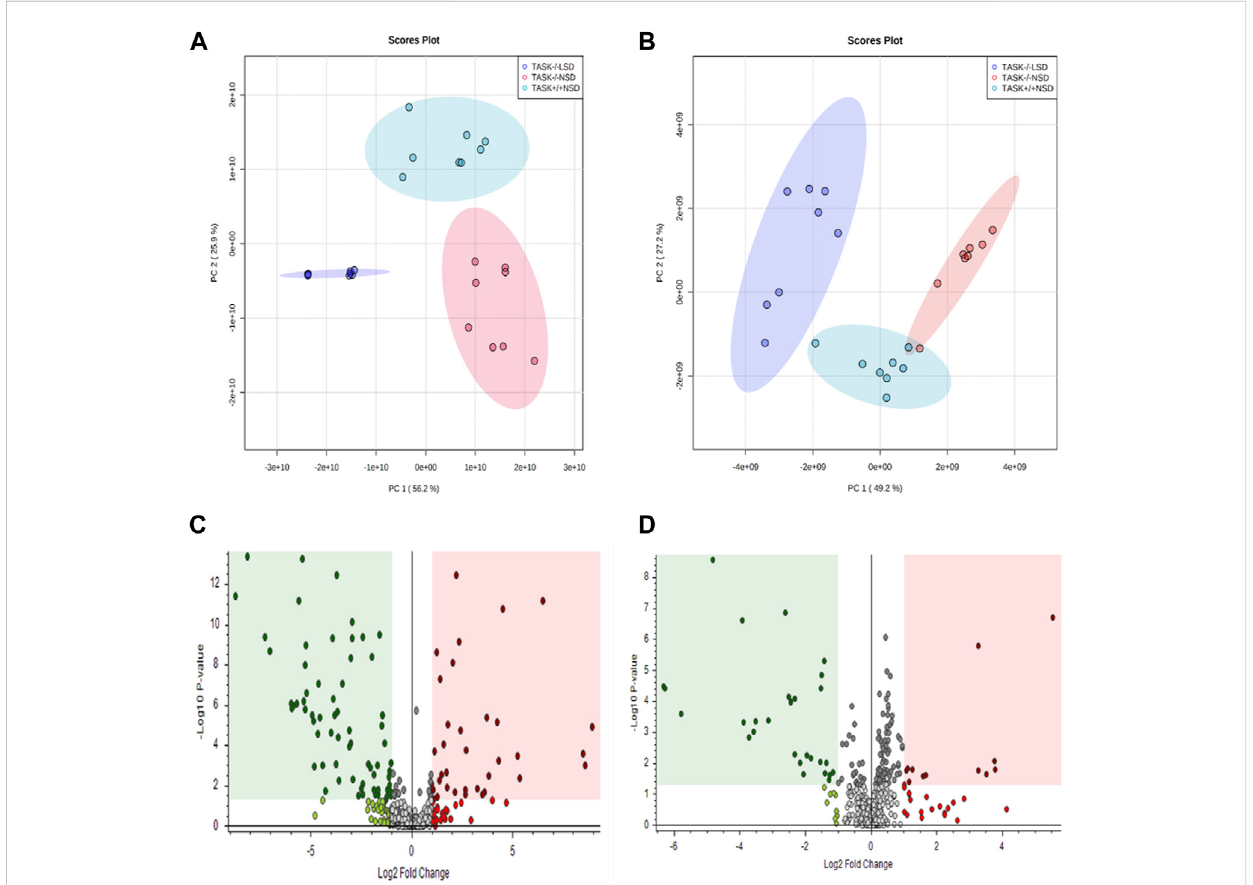
Principal component analysis and volcano plots of detected metabolites in positive mode and negative mode. PCA scores were plotted using positive (A) and negative (B) ion mode datasets for the TASK +/+ -NSD, TASK − / − -NSD, and TASK − / − -LSD groups. PC1, Principal component 1; PC2, Principal component 2. The volcano plots show the differential expression of metabolites between the TASK +/+ -NSD and TASK − / − -NSD groups under positive (C) and negative (D) ion mode. Log 2 Fold change is shown for TASK − / − -NSD versus TASK +/+ -NSD. The pink areas represent signi fi cantly upregulated metabolites, and the green areas indicate signi fi cantly downregulated metabolites, based on Log 2 Fold change and p -values <